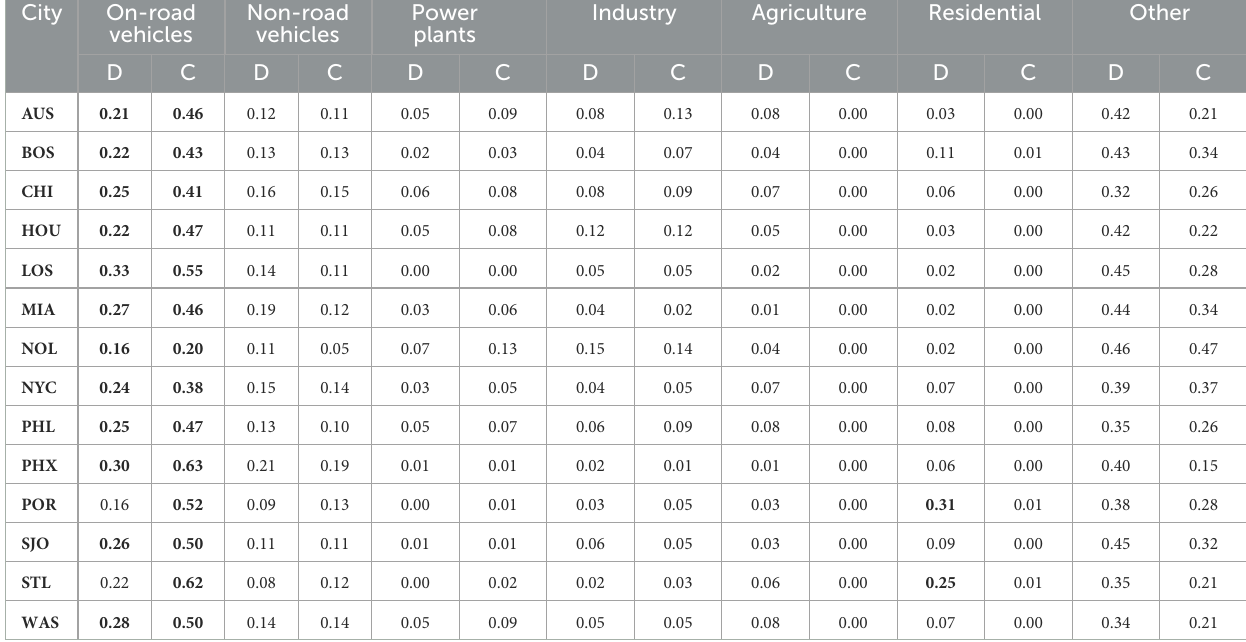
TABLE 3 Normalized sectoral contributions to PM 2.5 - and O 3 -related premature deaths (D) and NO 2 -related asthma cases (C) by the largest contributing sectors from emissions across the entire domain for all study cities.